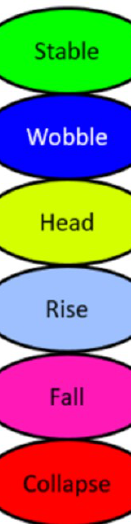
Figure 4. Descriptions of stages of control including color code.